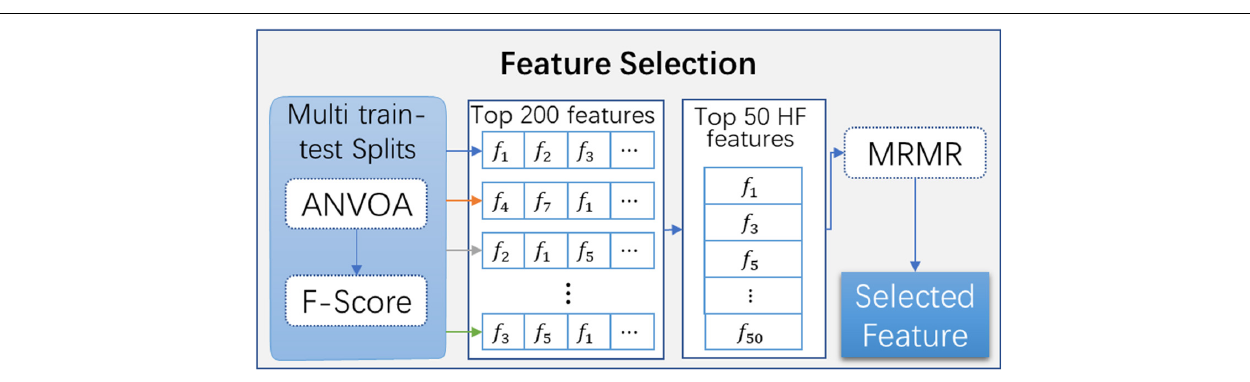
FIGURE 3 | The method for feature selection. HF, high frequency; ANOVA, analysis of variance; MRMR, minimum redundancy maximum relevance.